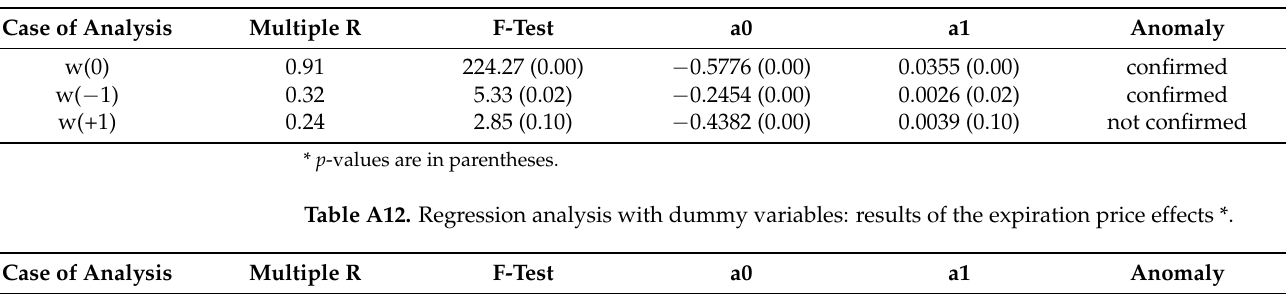
Table A11. Modified CAR approach: results of the expiration price effects *.